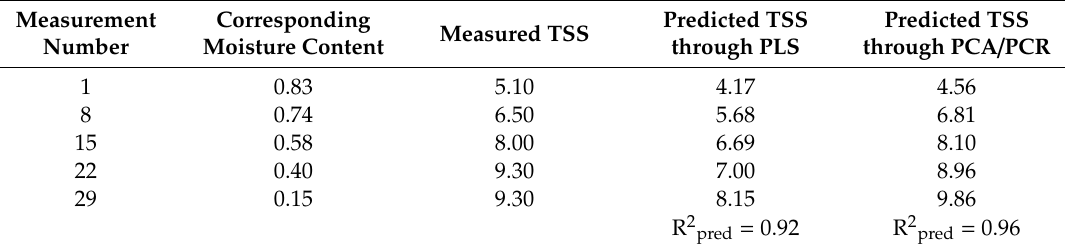
Table 4. Results of TSS prediction of the rehydration